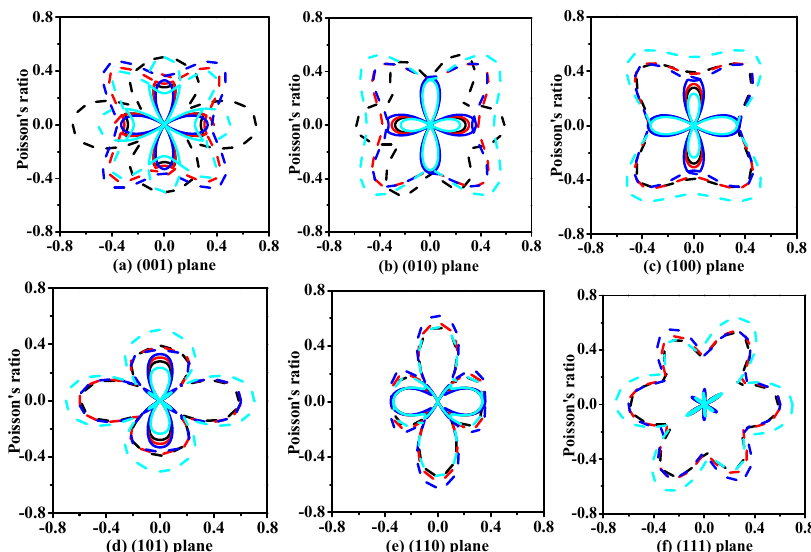
Figure 4. Two-dimensional (2D) representations of Poisson’s ratio for t -Si x Ge 3 − x N 4 ( x = 0, 1, 2, 3) alloys in the (001) plane ( a ); (010) plane ( b ); (100) plane ( c ); (101) plane ( d ); (110) plane ( e ); and (111) plane ( f ). The dash dot and solid lines represent the maximum and minimum values, respectively. The black, red, blue, and cyan lines represent the Poisson’s ratios of t -Si 3 N 4 , t -Si 2 GeN 4 , t -SiGe 2 N 4 , and t -Ge 3 N 4 , respectively.